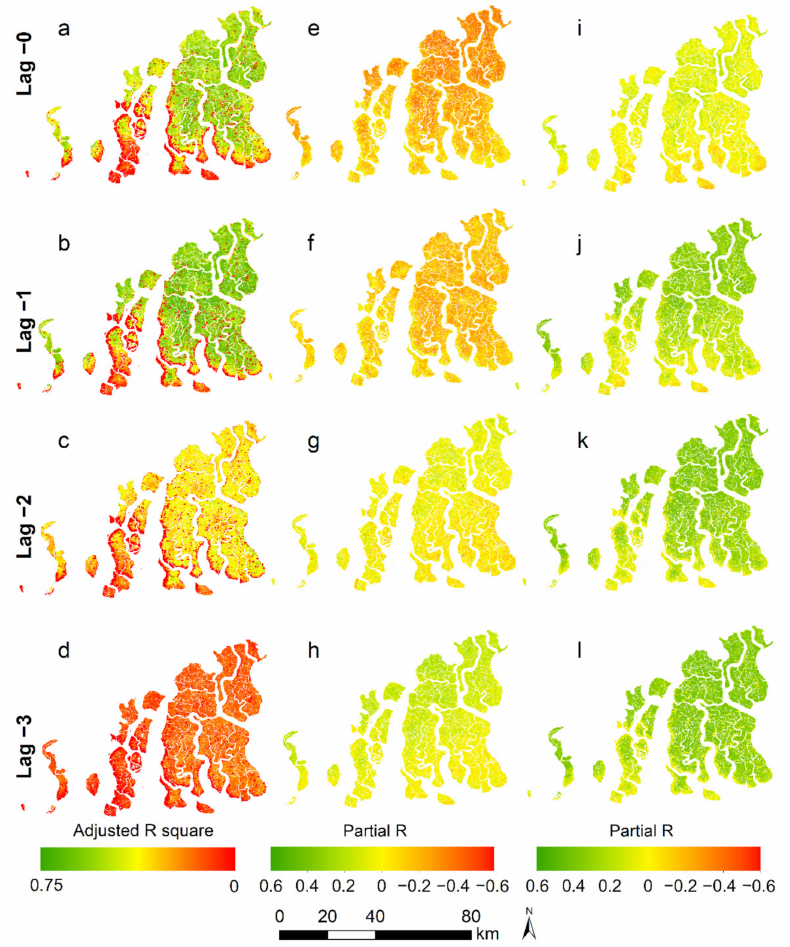
Figure 9. Adjusted R square ( a – d ), partial R EVI-rainfall ( e – h ), and EVI-maximum temperature ( i – l